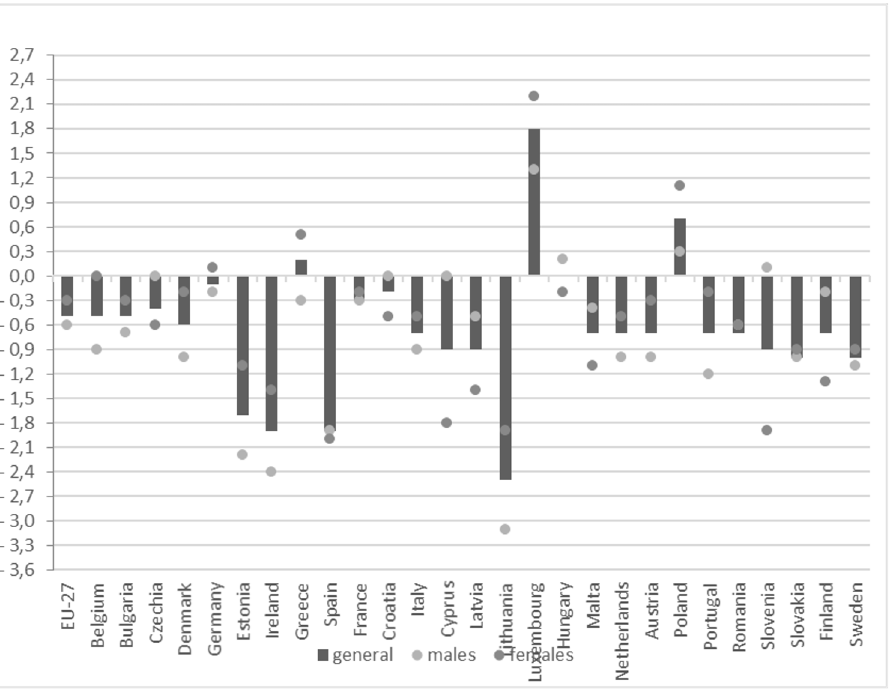
Figure 3. Change in employment – 2020Q1 – 2020Q4 (pp. based on % of total em- ployment in the group on females and males, and in general 20–64